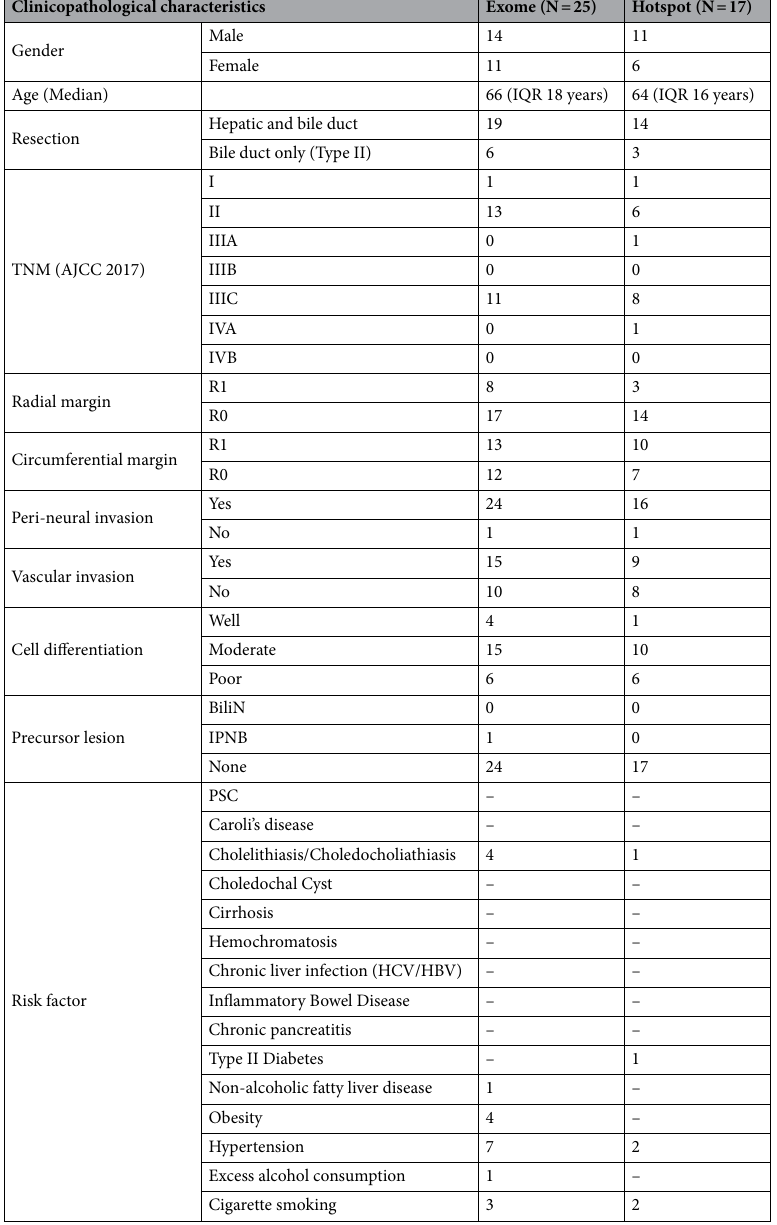
Table 1. Clinico-pathological characteristics of sequencing cohorts. Table summarizes the clinical and pathological characteristics of idiopathic PCCA patients included in this study. Histopathological staging is according to the AJCC 8th edition